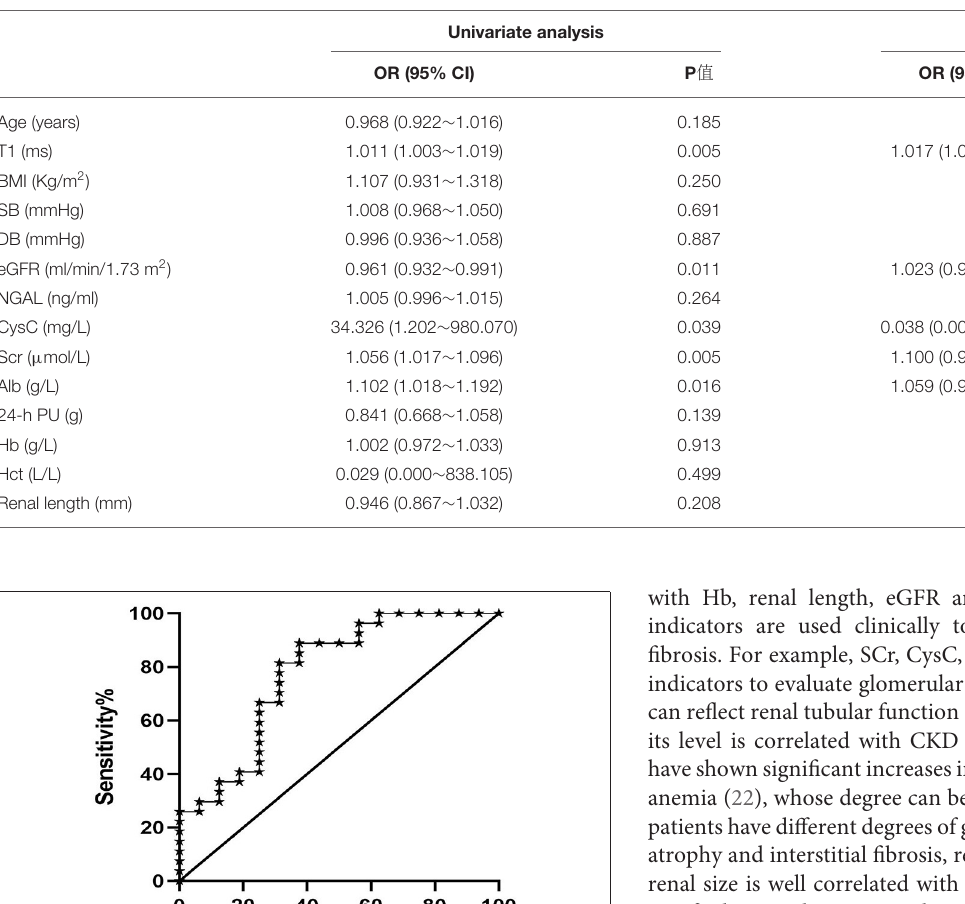
TABLE 2 | Influencing factors of renal fibrosis (Logistic regression analysis).